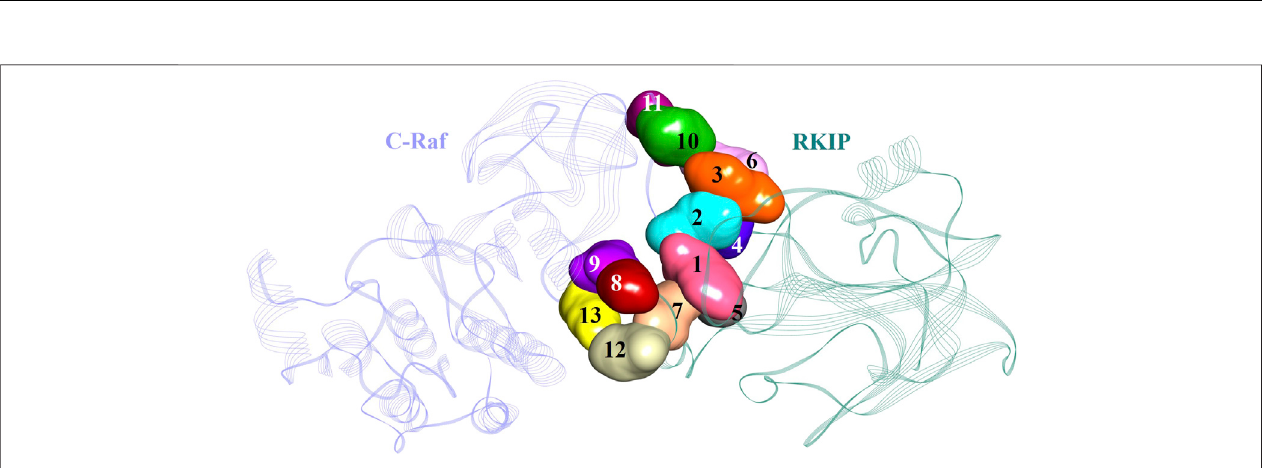
Frontiers in Molecular Biosciences |